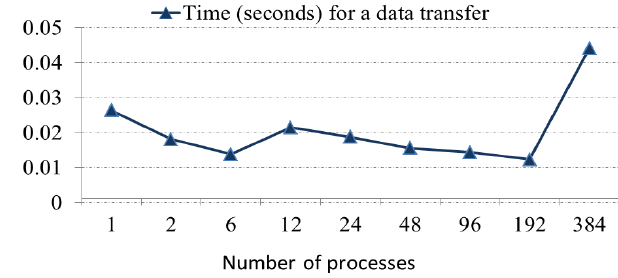
Figure 9. The scaling performance of a data transfer in MASNUM- Fig. 9. The scaling performance of a data transfer in the MASNUM-POM: transferring the 3-2 POM: transferring the 3-D field wave-induced mixing coefficient D field wave-induced mixing coefficient from the MASNUM to the POM. 3 from MASNUM to POM.